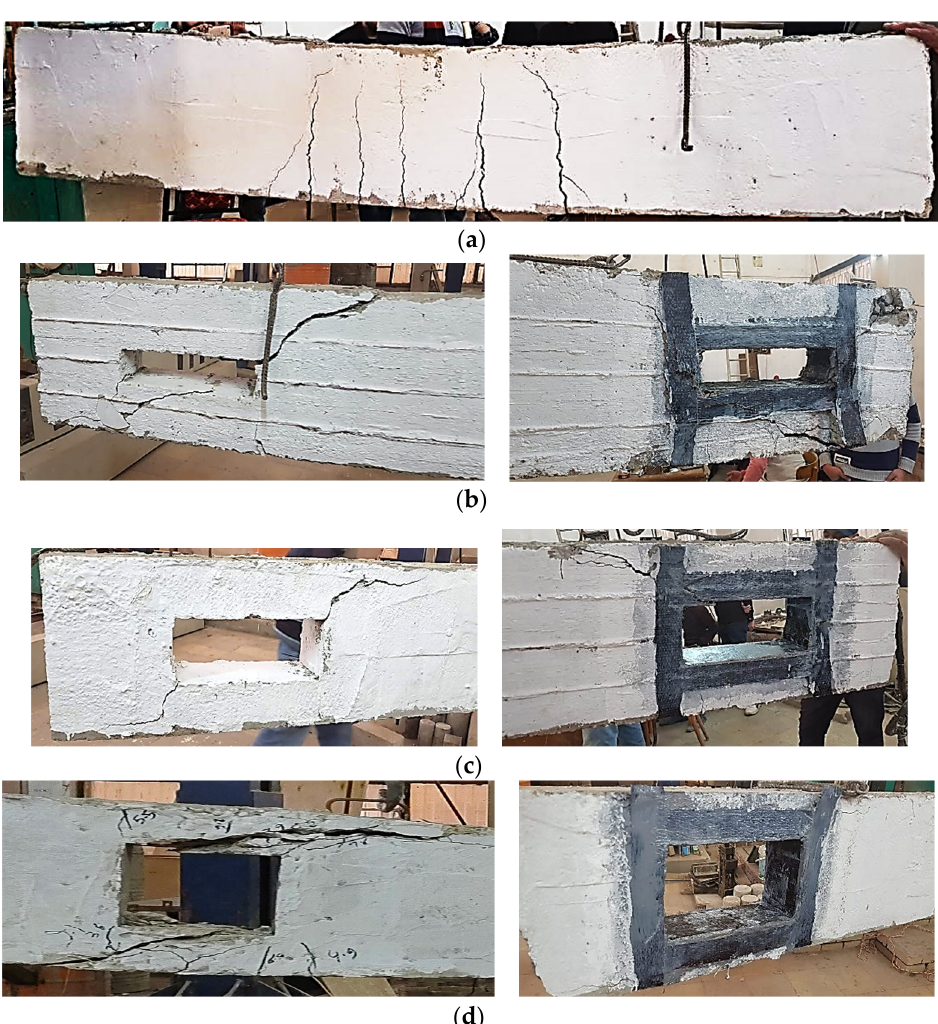
Figure 8. Failure Model of Samples with Shear-Zone Openings. ( a ) control beam; ( b ) opening 90 ×